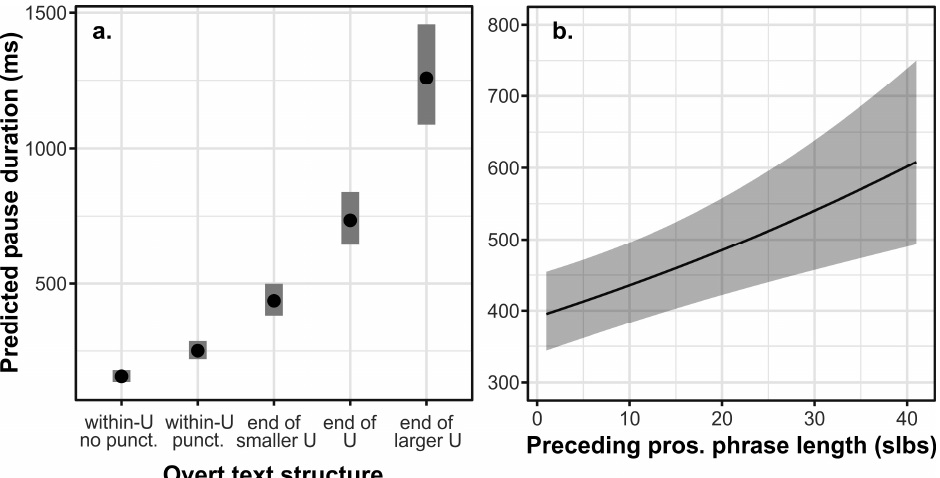
Figure 5. Predicted pause rate as a function of overt text structure (U = unit; punct. = punctuation). For an explanation of levels, see Section 2.3. The predictions of a Poisson regression model are back- transformed from log values to rates and relate to a sample of 100 potential pauses (dotted line).